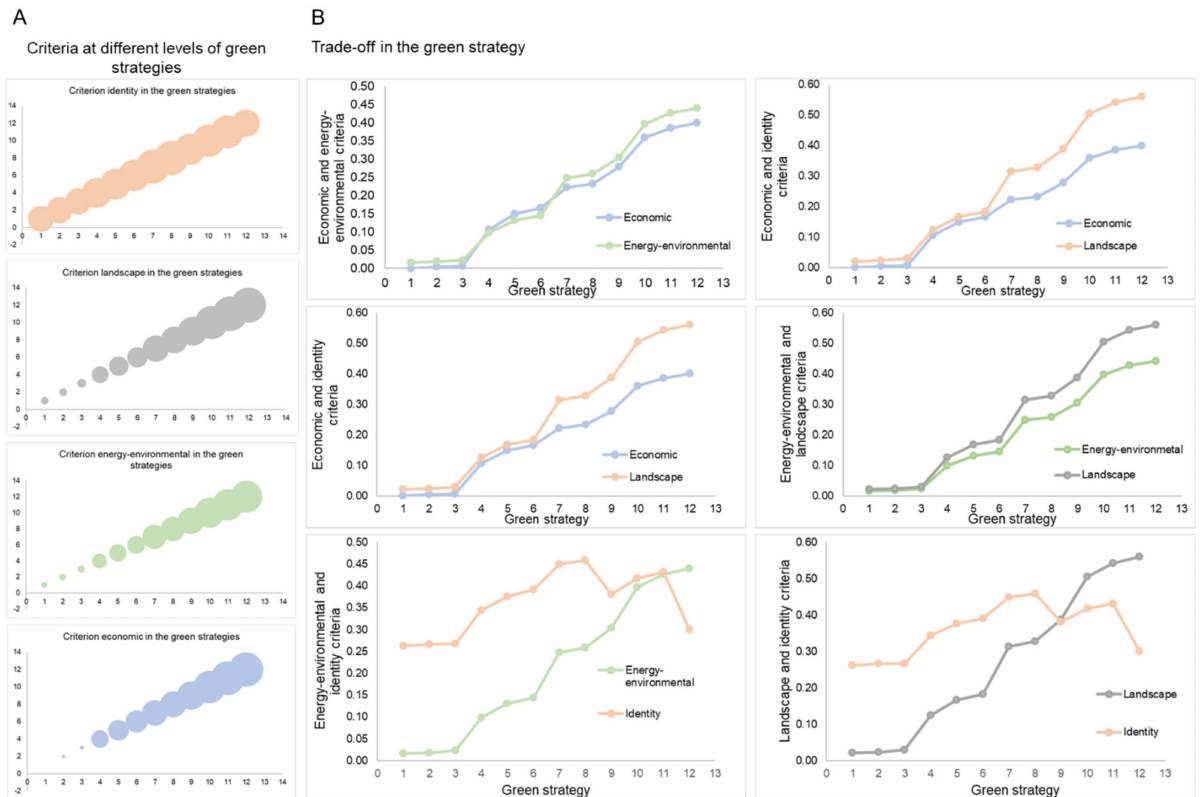
Figure 4. ( A ). Values of the criteria for the different levels of green strategy. ( B ). Trade-off between the criteria for the set of weights selected by the decision makers.